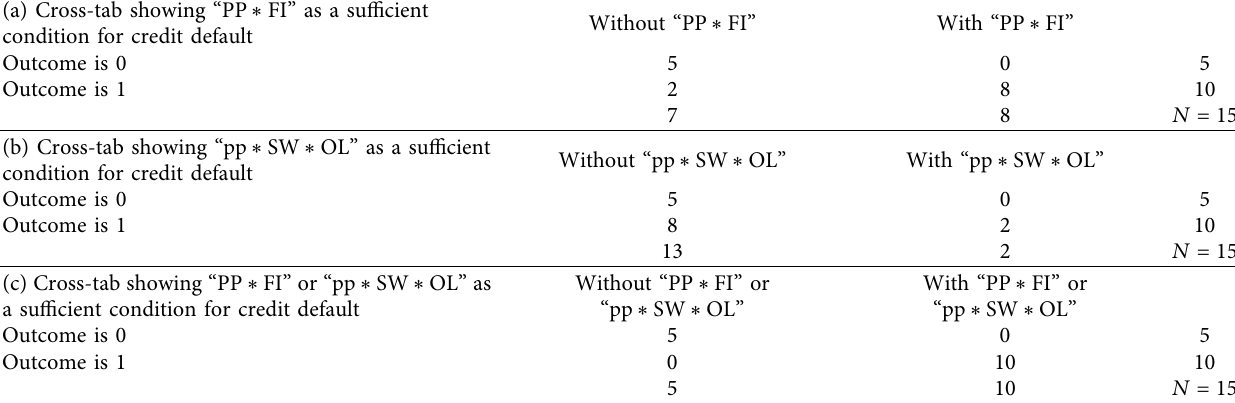
Table 9: Sufficient conditions with severe extent of credit default as the variable outcome. (a) Cross-tab showing “PP ∗ FI” as a sufficient condition for credit default